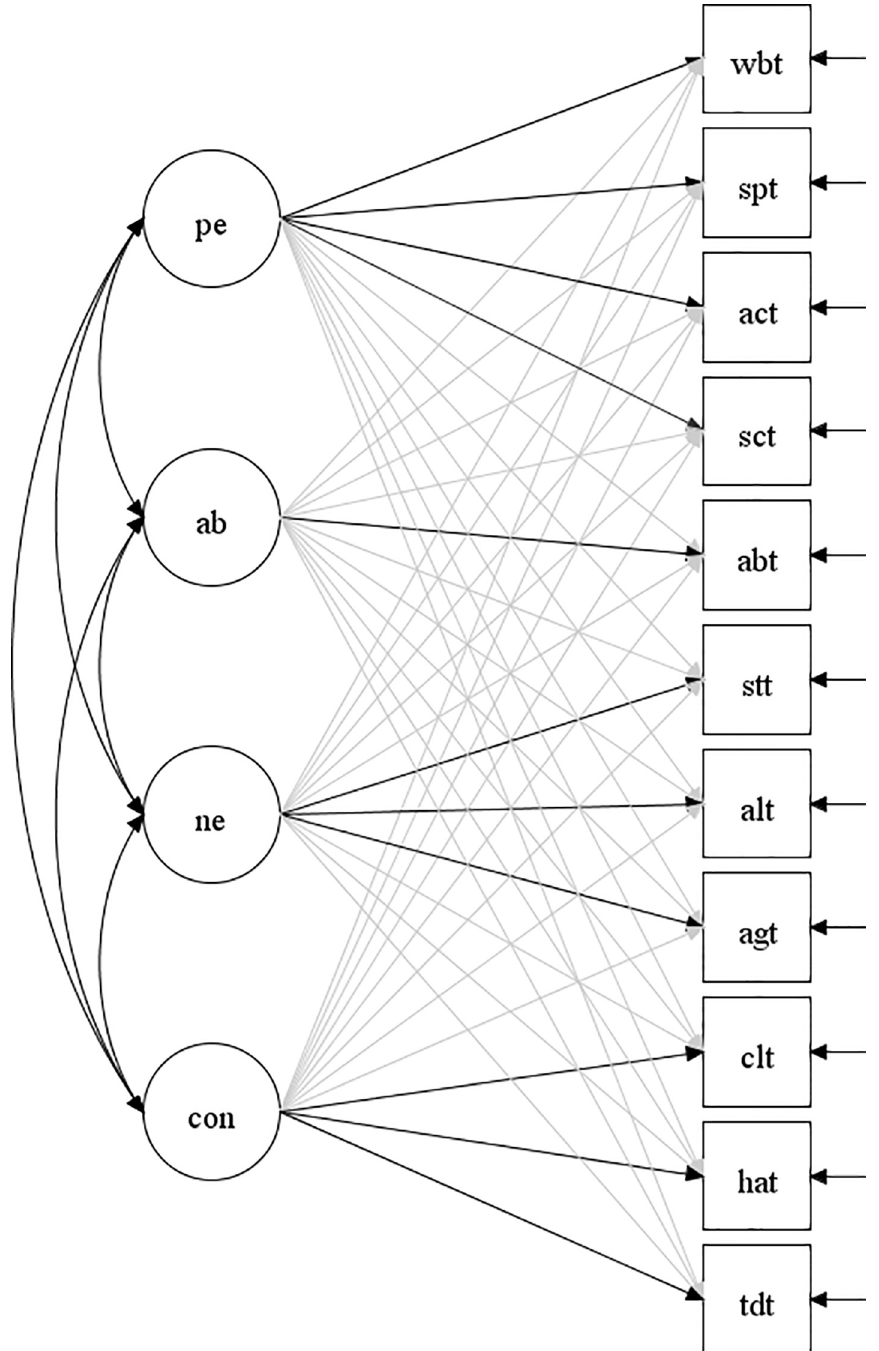
Fig 1. Conceptual representation of ESEM model at the lower-order primary trait level tested in the study (wbt = Wellbeing; spt = Social potency; act = Achievement; sct = Social closeness; abt = Absorption; stt = Stress reaction; alt = Alienation; agt = Aggression; clt = Control; hat = Harm avoidance; tdt = Traditionalism; pe = Positive Emotionality, ab = Absorption; ne = Negative Emotionality; con = Constraint. The darker arrows indicate the primary trait scale scores loading on their target higher-order factors, and the lighter arrows indicate the primary trait scale scores loading on non-target higher-order factors).